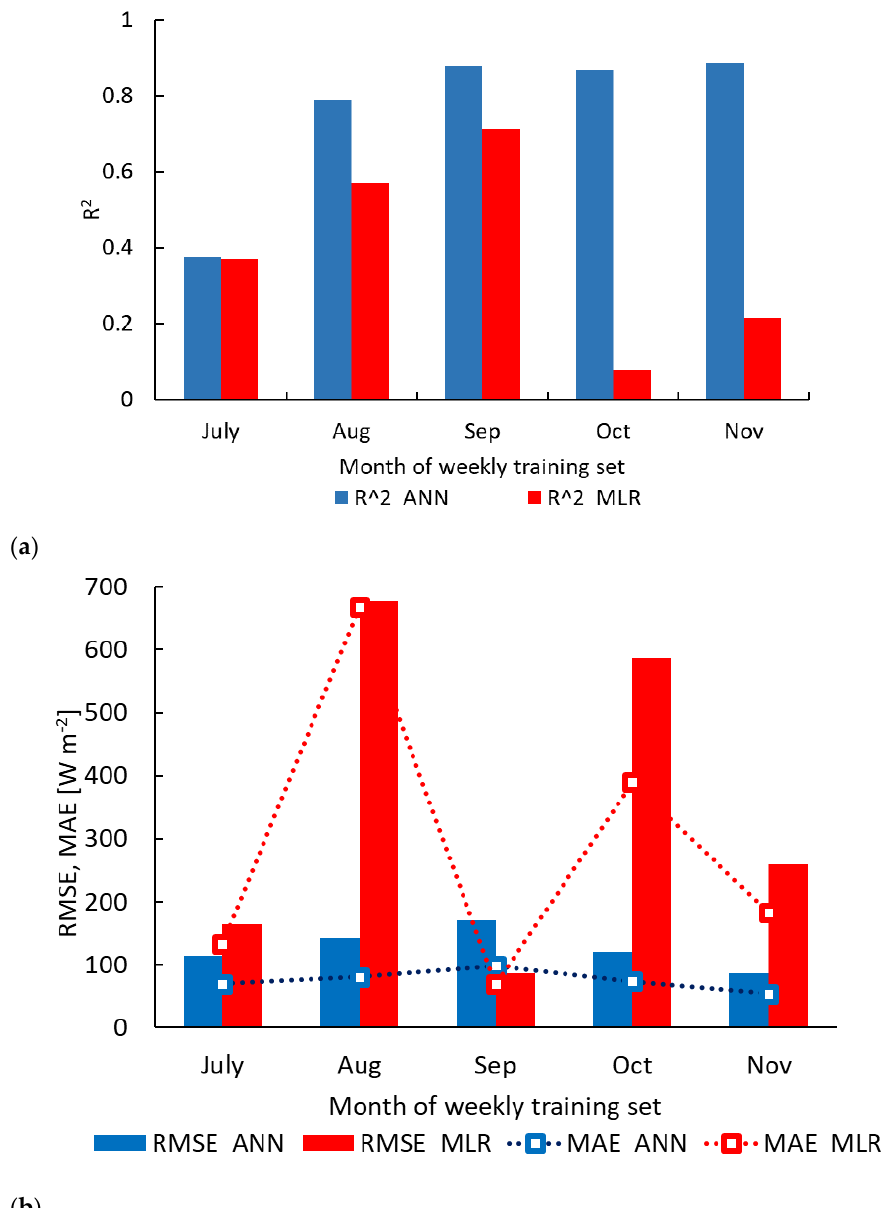
Figure 4. Comparison between R 2 , RMSE and MAE of ANN and MLR models trained using a one-week dataset (the first week of the month) and validated over the rest of the data (134 days) during the 2017 season. ( a ) R 2 ; ( b ) RMSE and MAE. Legend: R 2 — bars, RMSE — bars, MAE — square symbols. MLR — red; ANN — blue.